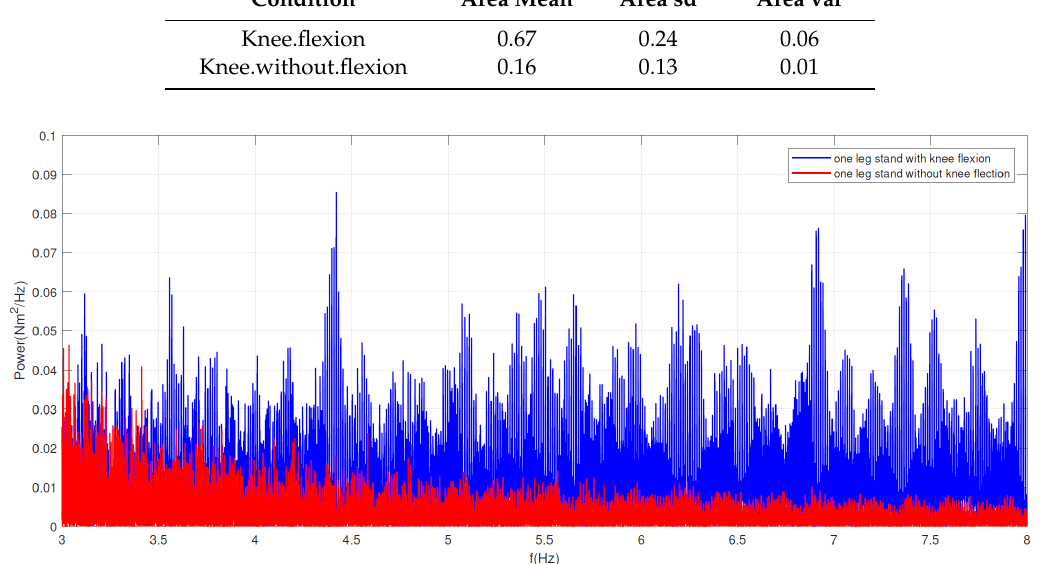
Table 2. Overview of the results of the assessment for knee flexion and without.